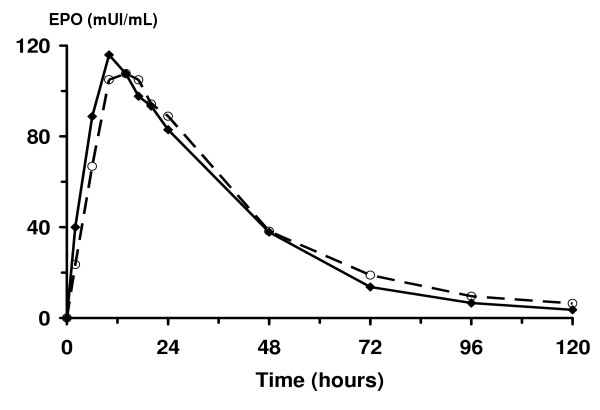
Average EPO concentration in serum. Data correspond to patients who received 100 IU/Kg of Heberitro (solid line) or Eprex (dashed line) at time 0. Standard deviations are not shown for the sake of simplicity of the illustration. Curves were not significantly different at any point in a multiple determinations ANOVA with Bonferrony's correction.